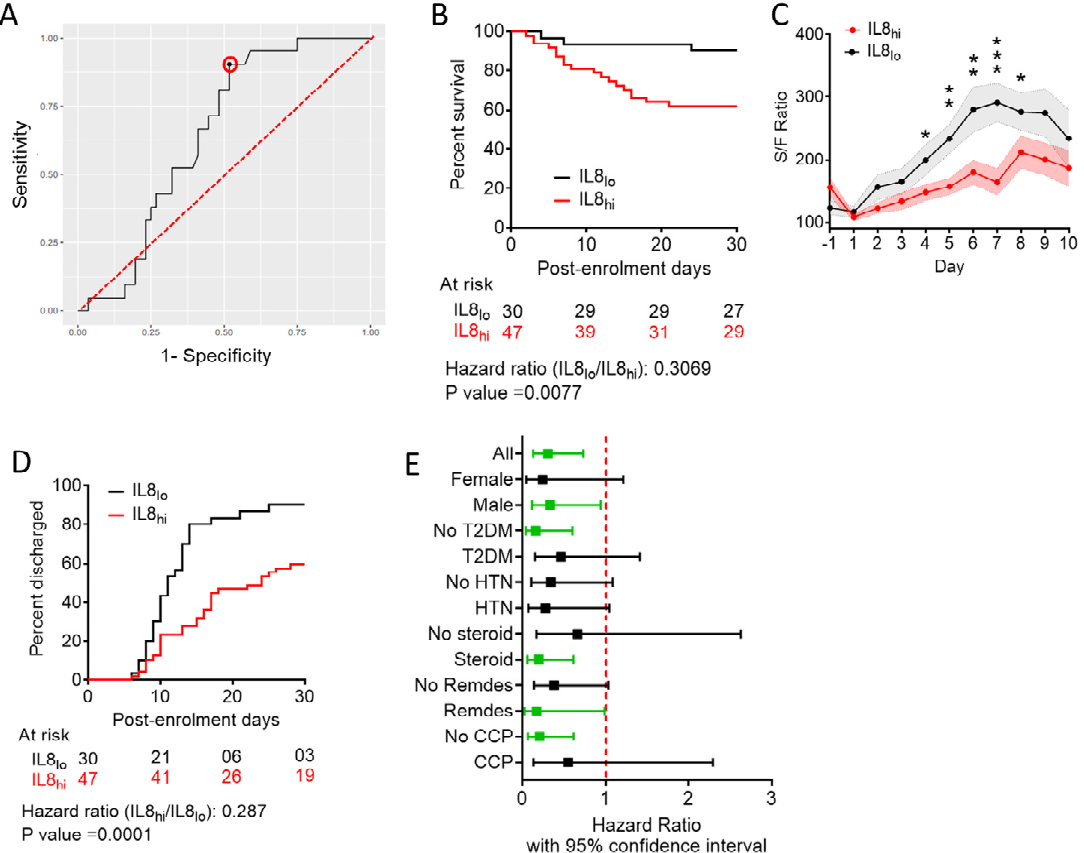
Figure 3. Plasma level of IL-8 and clinical outcomes in severe COVID-19 patients. ( A ) Receiver operator characteristic curve (black line) of plasma levels of IL-8 to derive remission versus non- remission (death), the marked point denotes the specificity and sensitivity with the derived cut-off (red circle). The red dotted line denotes the diagonal. ( B ) Survival of patients till day 30 post-enrolment is compared in a Kaplan–Meier curve between patients with plasma level of IL-8 below (IL8 lo , black line) or above (IL8 hi , red line) the cut-off derived from the ROC curve shown in ( A ). Surviving patients were censored on day 30 post-enrolment. ( C ) Comparison of SpO2/FiO2 ratio kinetics over 7 days following plasma sampling between IL8 lo (black line) and IL8 hi (red line) subgroup of patients. * p < 0.05, ** p < 0.005, *** p < 0.0005 from unpaired t -tests. ( D ) Hospital stay duration (time to remission) of the patients from both groups, IL8 lo (black line) and IL8 hi (red line), since the day of enrolment is plotted in an ascending Kaplan–Meier curve. Deaths and non-remission at day 30 post-enrolment were censored. For the outcome comparisons shown in ( B , D ) Mantel–Cox log-rank test was performed. Number of patients at risk on different days and the Mantel–Haenszel hazard ratio is shown. ( E ) Mantel–Haenszel hazard ratio for Kaplan–Meier analysis for survival in subgroups of patients, for IL8 lo patients, compared with IL8 hi patients. Analyses showing Mantel–Cox log-rank test p -values <0.05 are indicated in